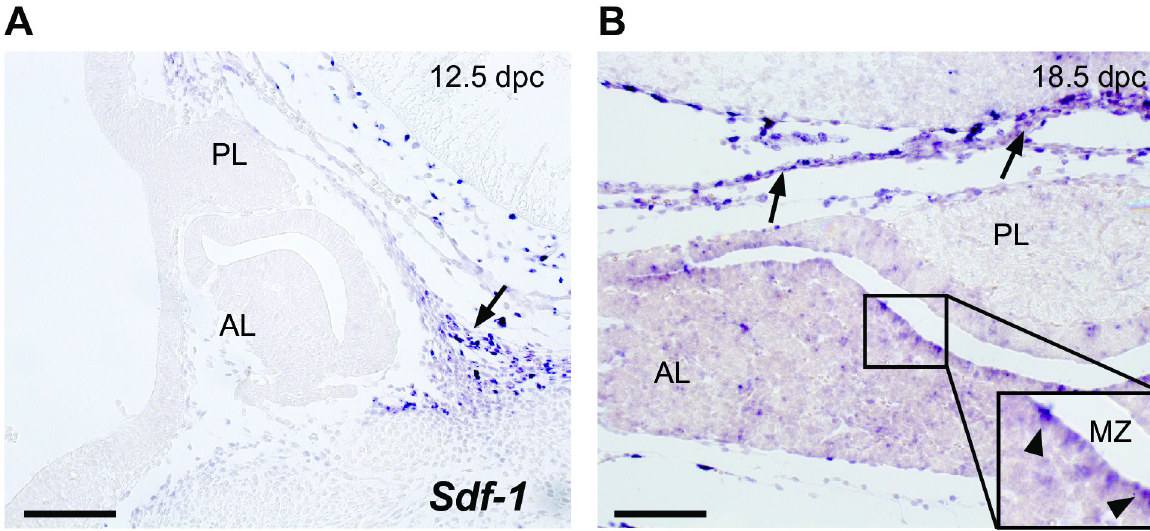
Fig 4. The expression pattern of Sdf-1 during murine pituitary development. (A) In situ hybridisation (ISH) at 12.5 dpc shows that SDF-1 mRNA expression is localized in mesenchymal tissue surrounding the developing pituitary gland (arrow). (B) At 18.5 dpc, the supportive mesenchyme still expresses SDF-1 mRNA (arrows), although positive cells are also scattered throughout the anterior lobe. Inset: the periluminal region or marginal zone also contains positive cells (arrowheads). Scale bars: 100 μ m; AL: Anterior Lobe; PL: Posterior Lobe; MZ: Marginal Zone.